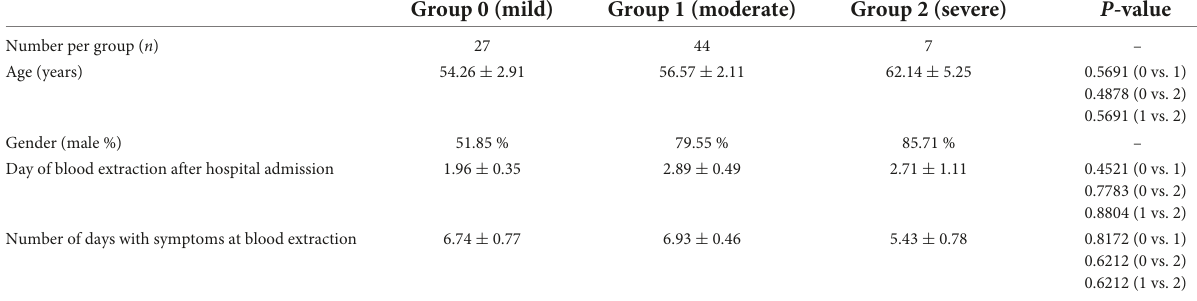
TABLE 1 Demographic and clinical features of